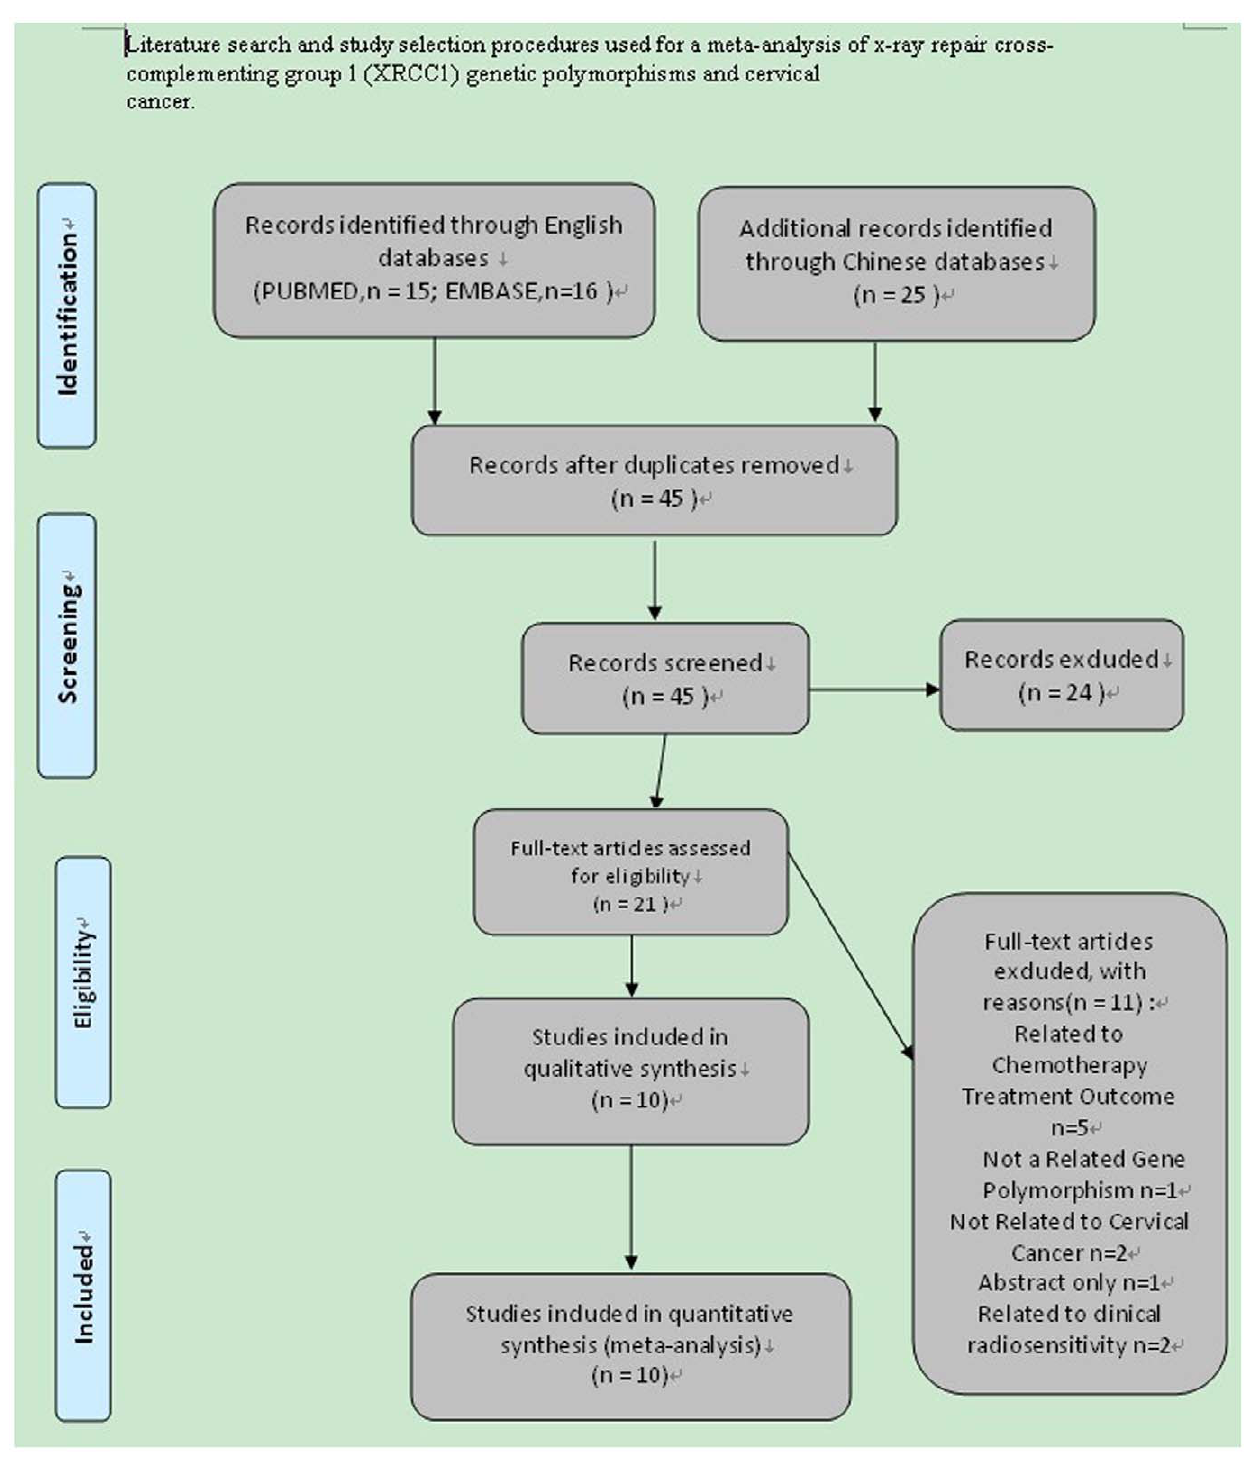
Figure 1. Literature search and study selection procedures used for a meta-analysis of x-ray repair cross-complementing group 1 (XRCC1) genetic polymorphisms and cervical cancer.